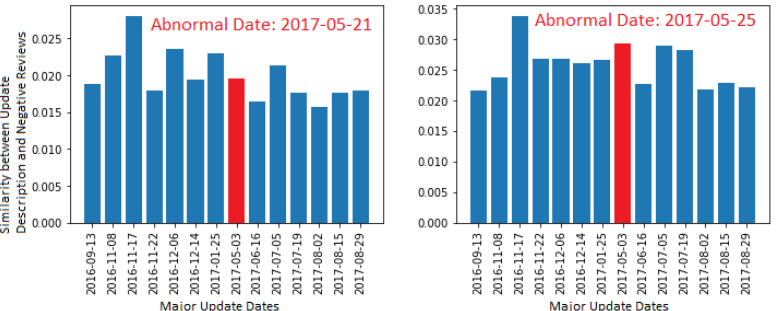
Figure 7. Similarity between update description and negative reviews of abnormal days for